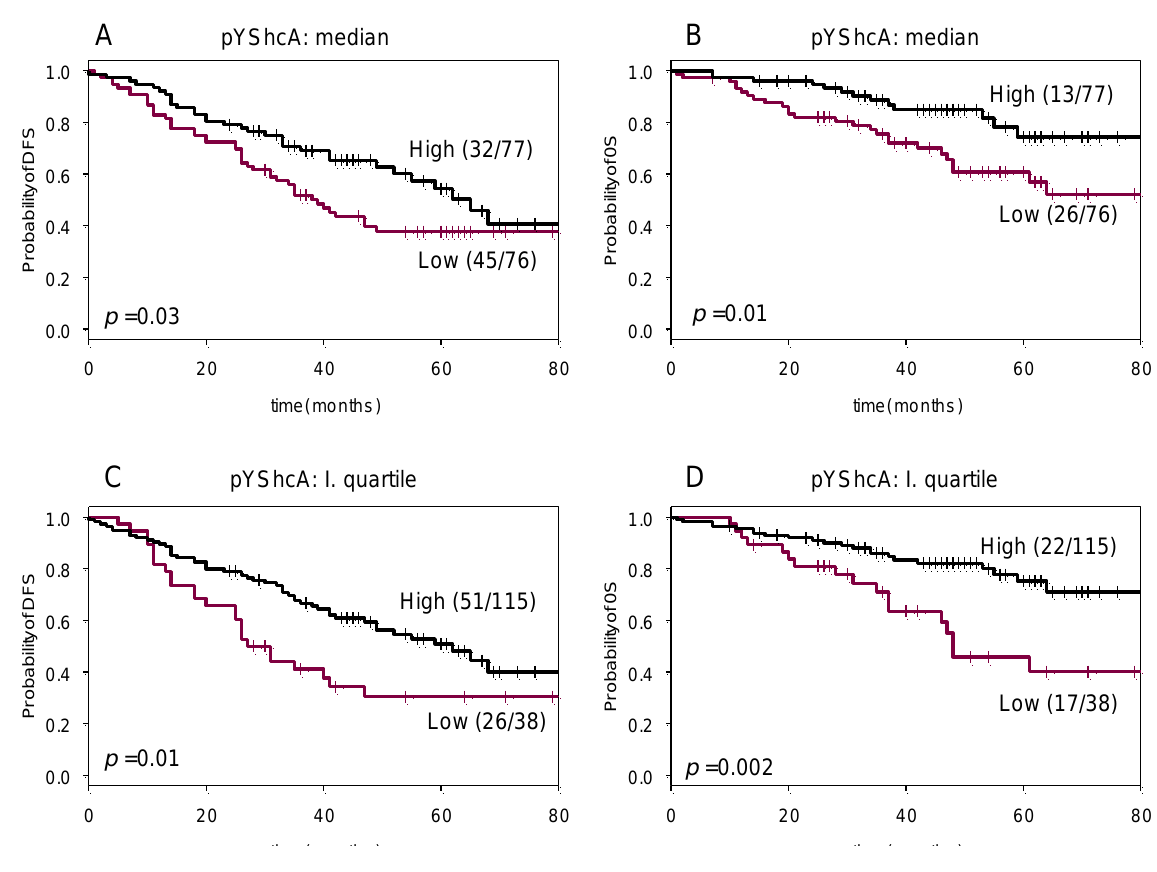
Figure 3. Kaplan–Meier survival curves for pYShcA. Patients were dichotomized according to the median ( A , B ) or first quartile expression value of pYShcA ( C , D ). Disease-free survival (DFS) ( A , C ) and overall survival (OS) in ( B , D